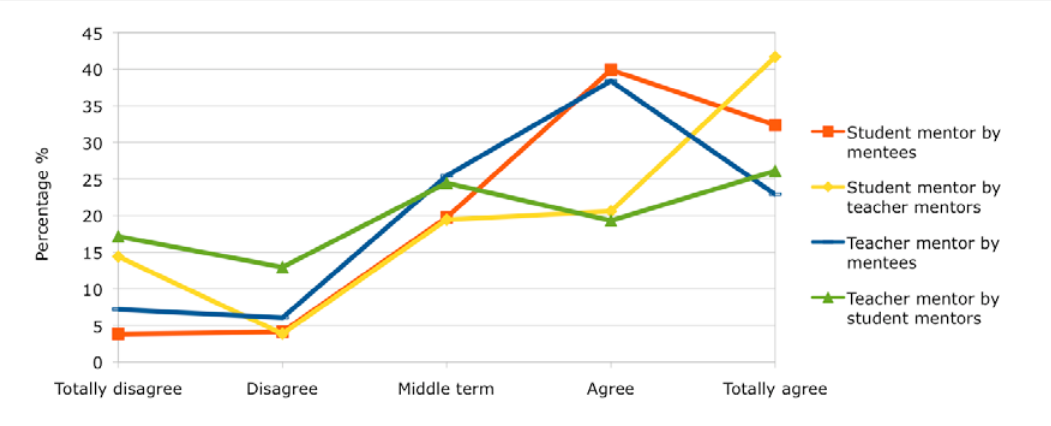
Figure 3. “Utility of the participation of mentors in the individual meetings”.